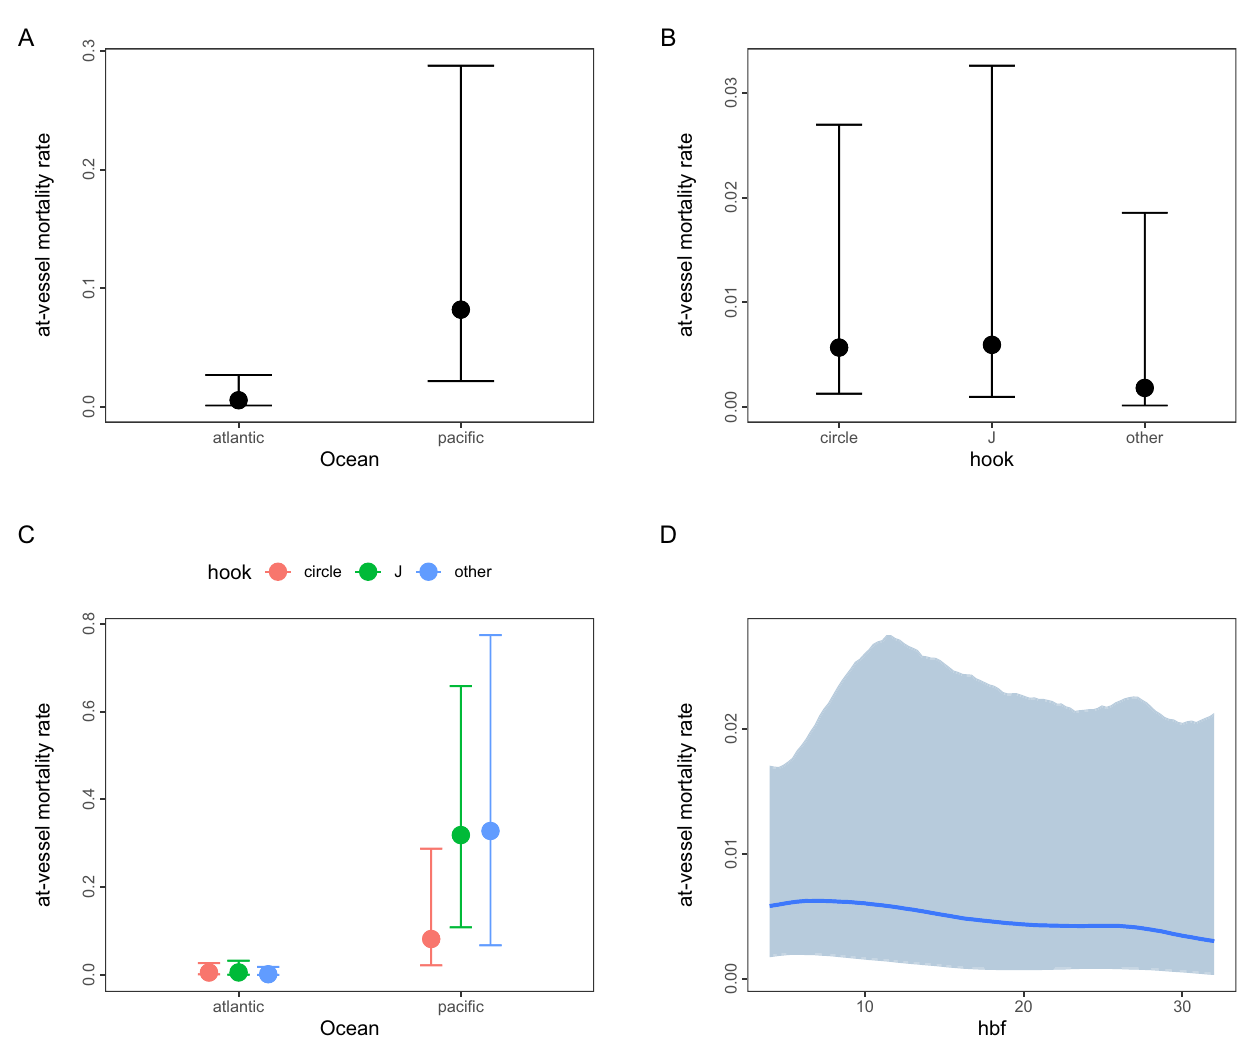
Figure 3. PELAGIC STINGRAY. Graphical summary of the Bayesian meta-regression model (binomial- Normal GAMM) fitted to 90 AVM effect sizes compiled for the pelagic stingray. Panel ( A ) shows the estimated conditional ocean-specific AVM rate. Panel ( B ) shows the estimated conditional hook shape effect on AVM. Panel ( C ) shows the estimated conditional effect of hook shape within ocean basin effect on AVM. Panel ( D ) shows the estimated conditional effect of number of hooks between floats on AVM. Solid dot = posterior mean, vertical bar = 95% credible interval, solid curve = mean nonlinear trend, shaded polygon = 95% pointwise credible